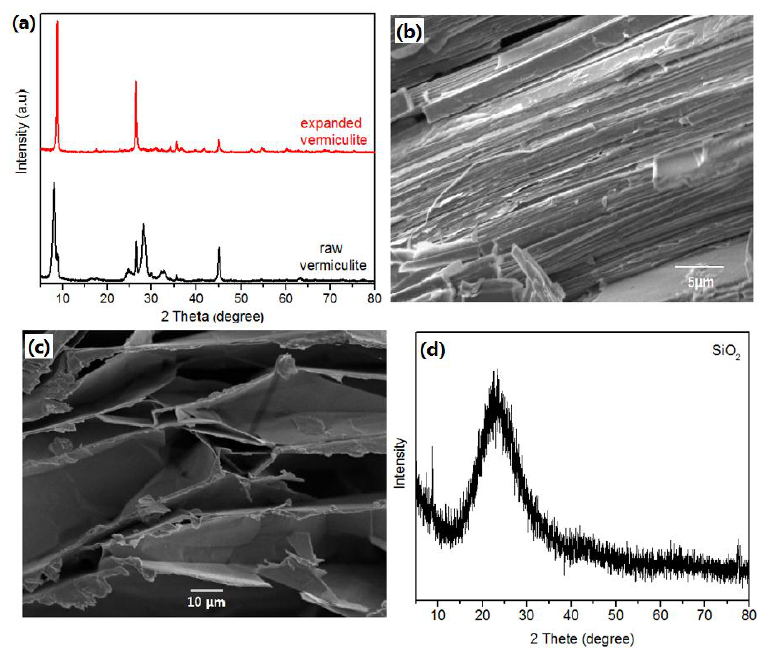
Figure 2. ( a ) The XRD patterns of VMT and EX-VMT, ( b ) SEM image of VMT, ( c ) SEM image of EX- VMT, and ( d ) XRD pattern of SiO 2 sample obtained with 6 M aqua regia.